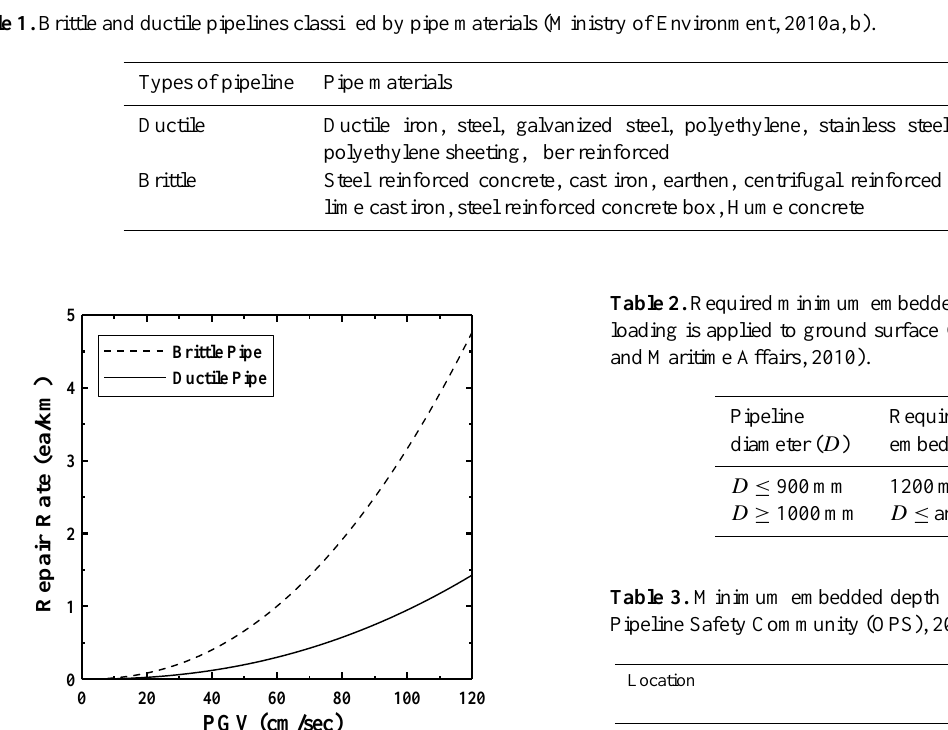
Fig. 1. Fragility curve of buried pipelines provided by HAZUS with the repair rate (RR) given as a function of the peak ground velocity (PGV) (FEMA, 1999).